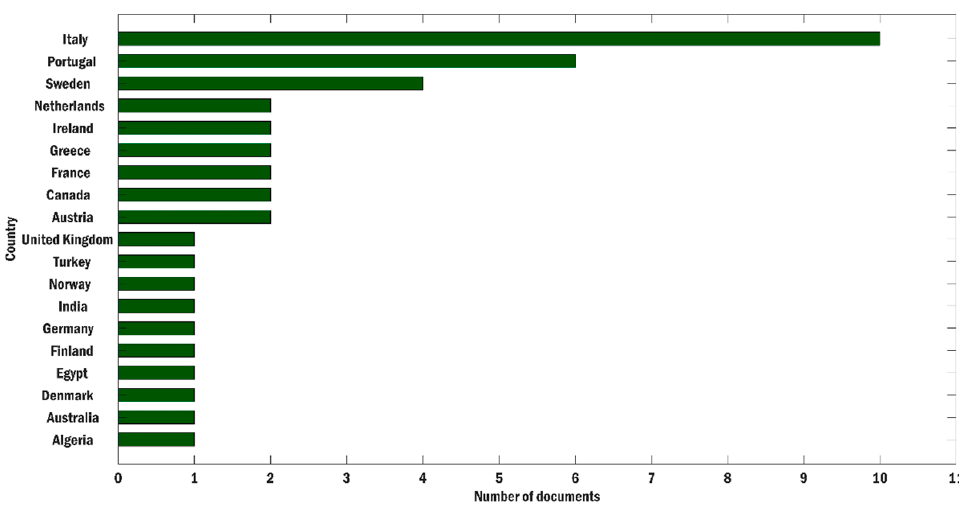
Figure 4. Number of publications during the years for the top territories until